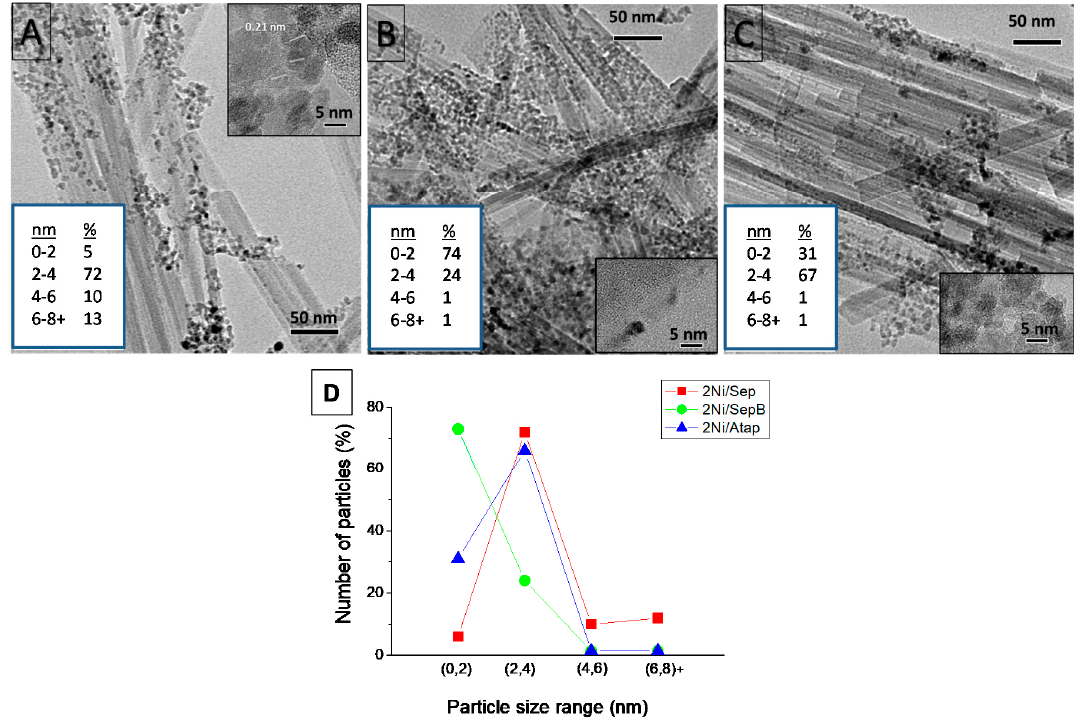
Figure 4. Representative HRTEM images for ( A ) 2Ni / Sep, ( B ) 2Ni / SepB and ( C ) 2Ni / Atap catalysts, and ( D ) distribution of the size of Ni particles in these catalysts.